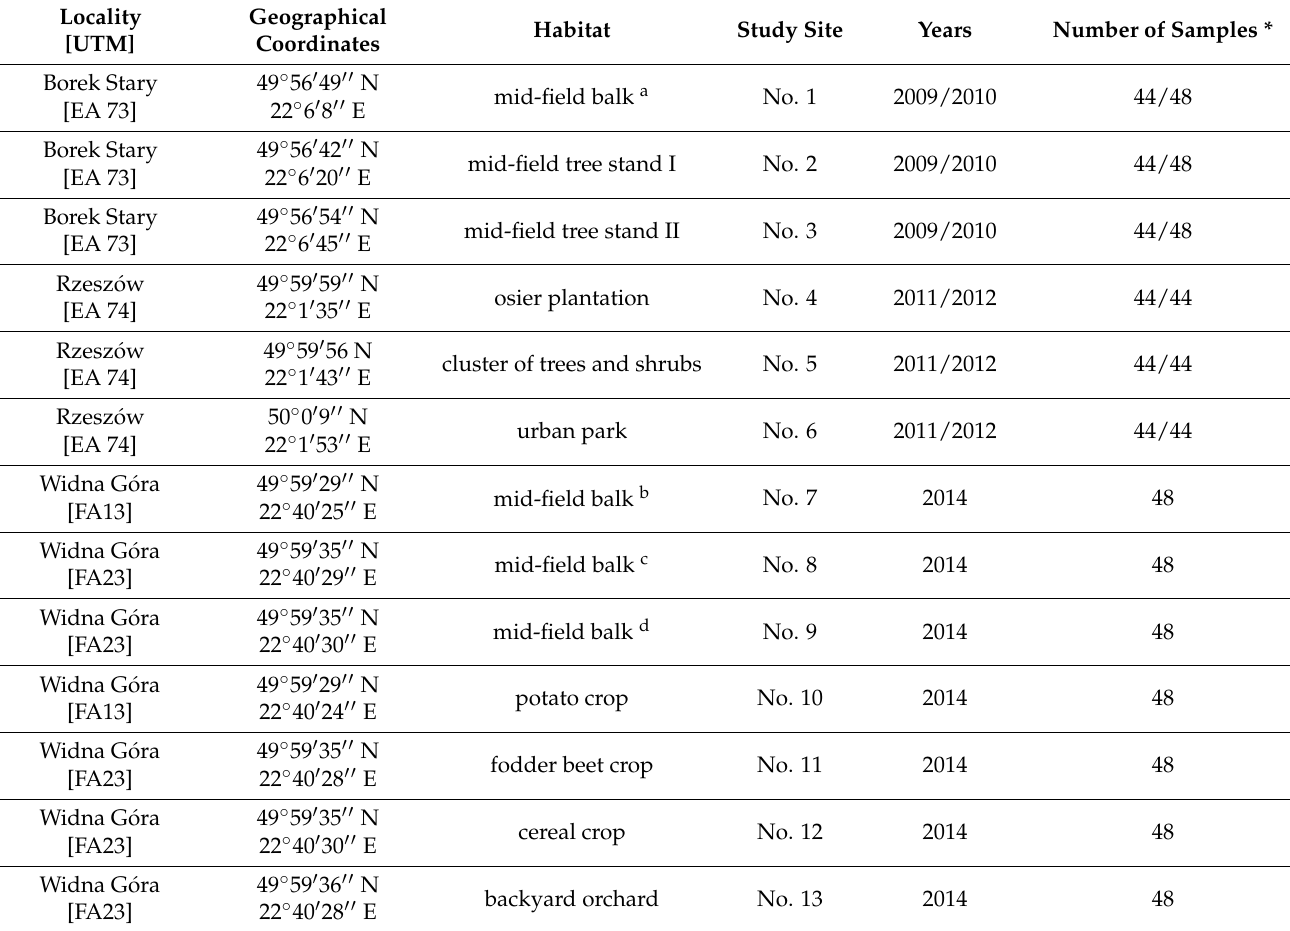
a —mid-field balk between cereal crop and pasture, b —mid-field balk between potato crop and meadow, c —mid-field balk between fodder beet crop and cereal crop, d —mid-field balk between cereal crop and meadow, *—one sample constituted the content of one pitfall trap at one study